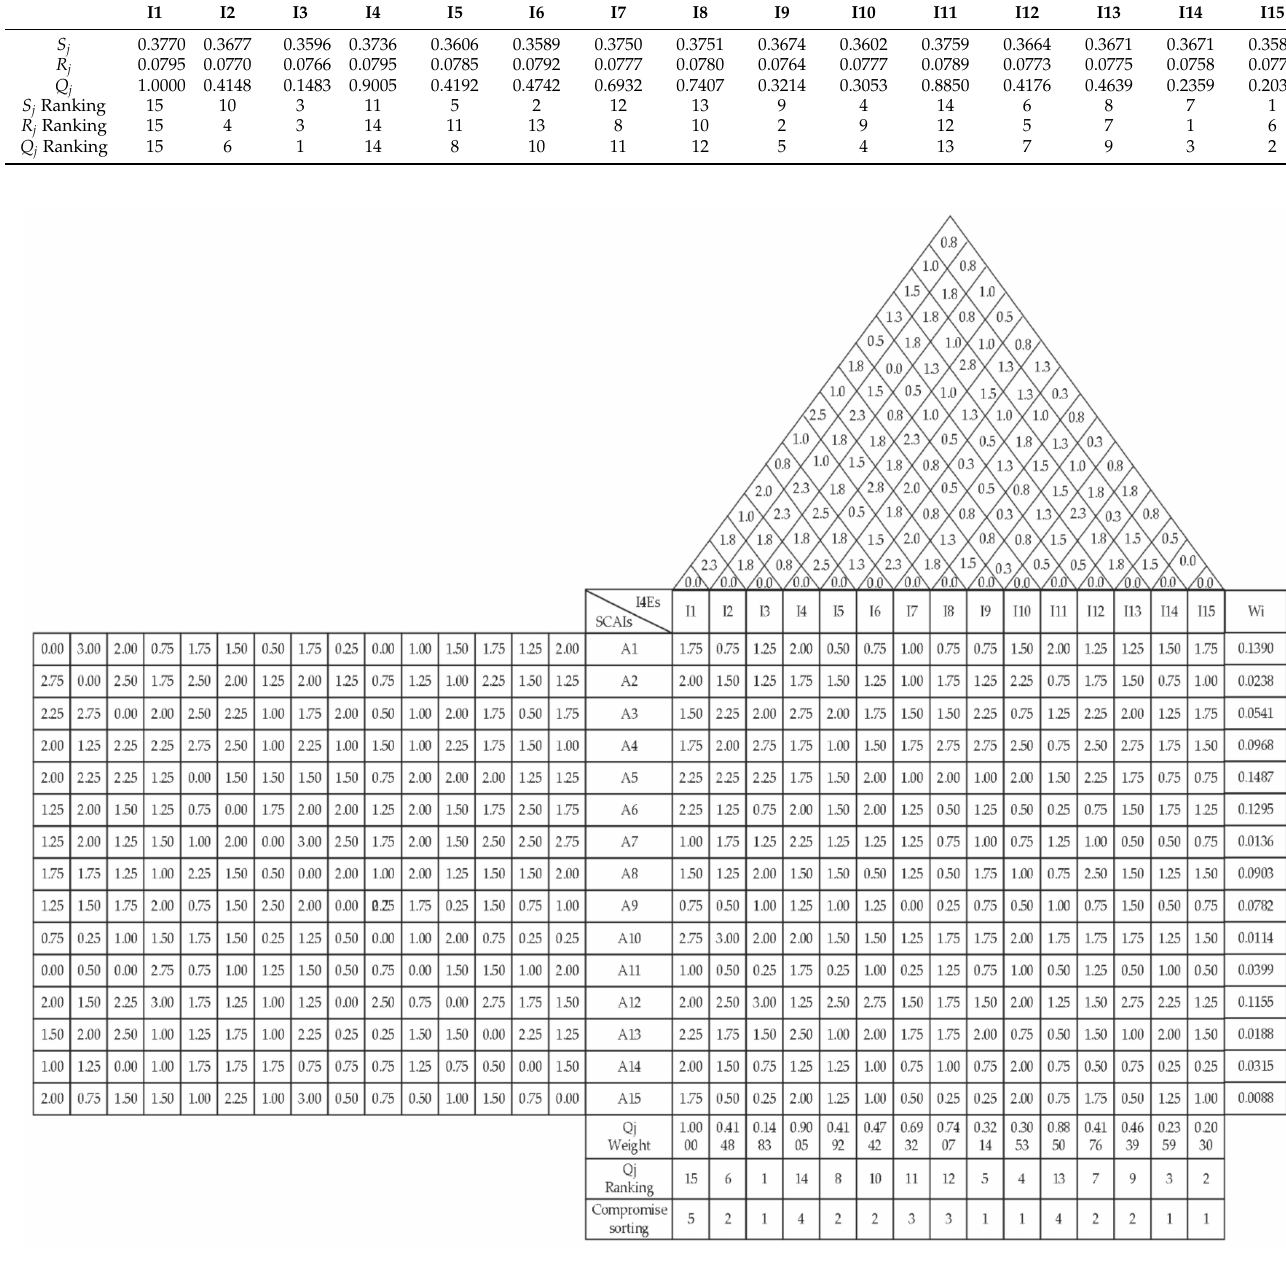
Figure 4. Second HoQ between SCAIs and